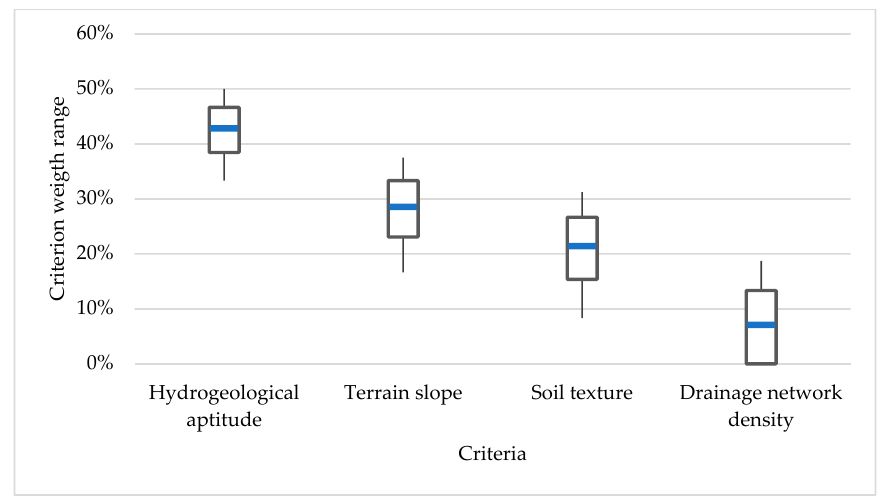
Figure 10. Range of weights used for the sensitivity analysis by adding or erasing one minor or one major effect between the criteria for the MIF methods.